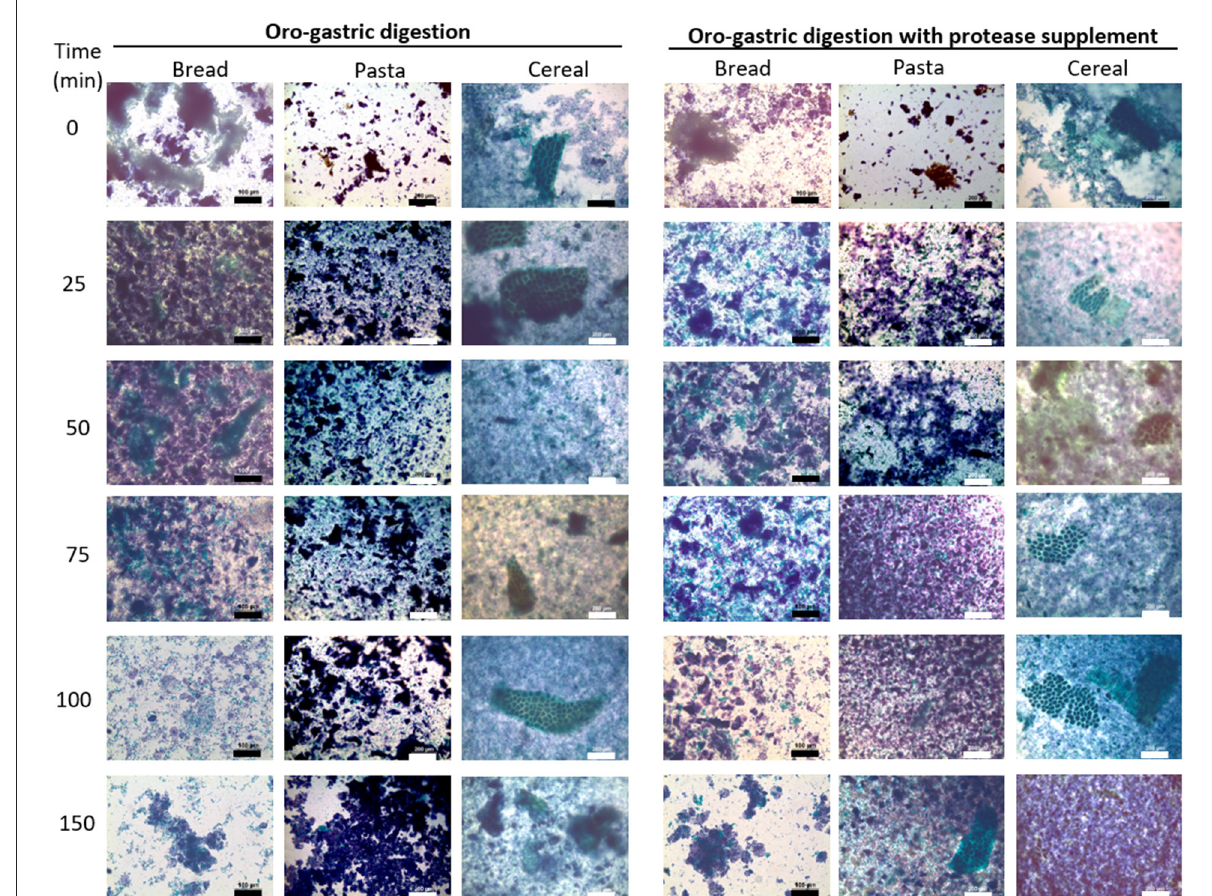
FIGURE3 Light micrographs of samples collected at the end of the oral phase (t0) and throughout during gastric digestion (25–150min) of bread, pasta and breakfast cereal. Micrographs on the right correspond to digestion experiments in which a commercial supplemental enzyme mix was added. Protein appears green and starch appears purple/blue due to staining with Light green and Lugol’s solutions, respectively. For bread digestion samples, bar length represents 100 µ m. For pasta and cereal digestion samples, bar length represents 200 µ